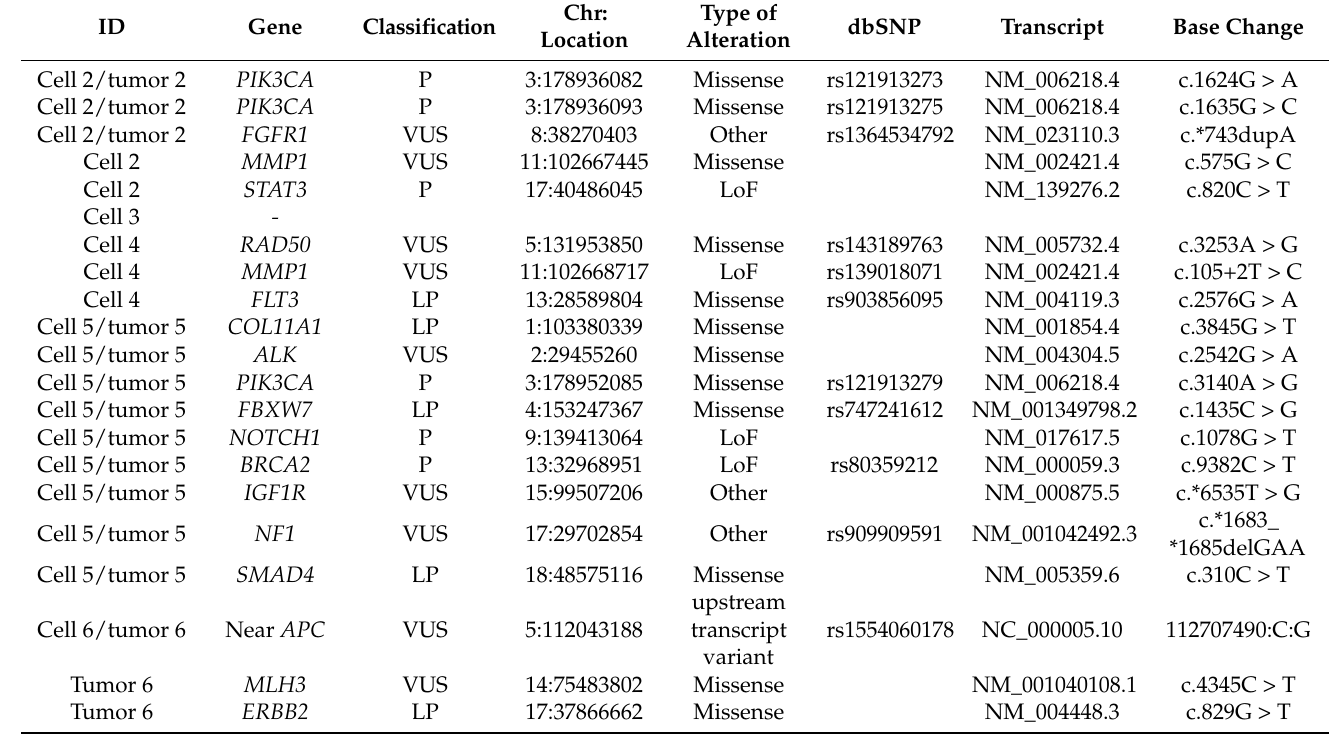
Table 2. Variants identified by targeted next-generation sequencing in the penile cancer-derived cell